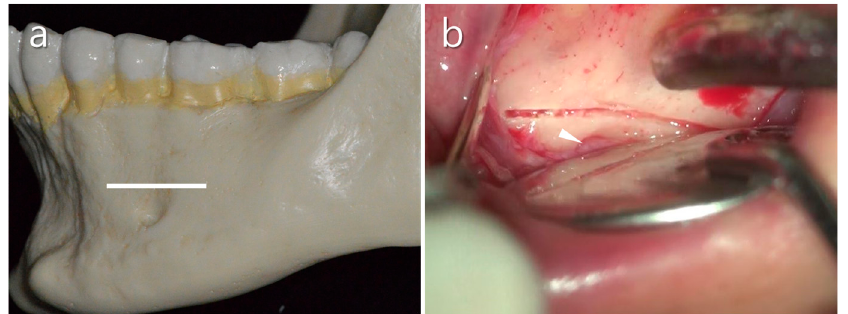
Figure 7. The groove technique. ( a ) A narrow horizontal groove is positioned just above the mental foramen (white line). ( b ) Clinical feature of a practically narrow groove made using the piezoelectric saw. Note that the nerve/vessel bundle comes from the foramen (white arrow).